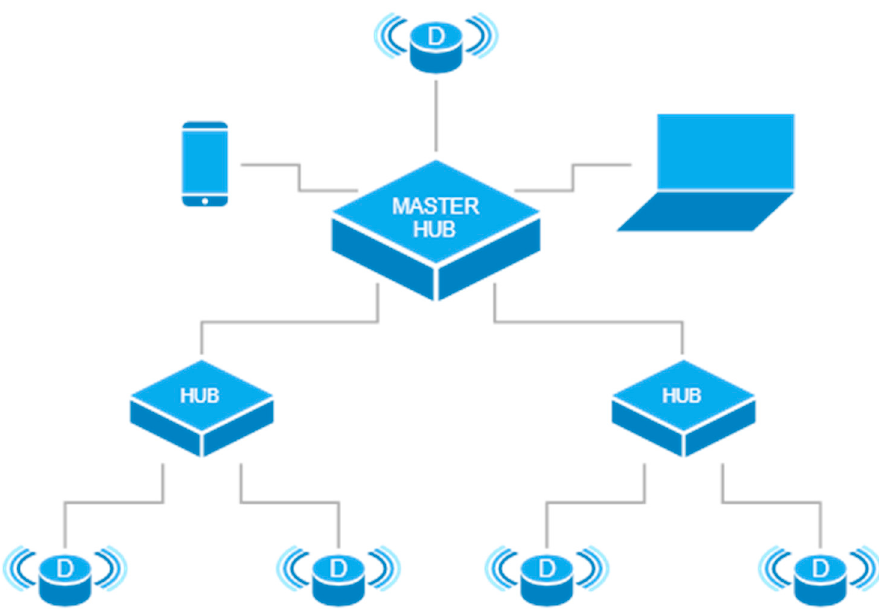
Figure 2. The qToggle topology.